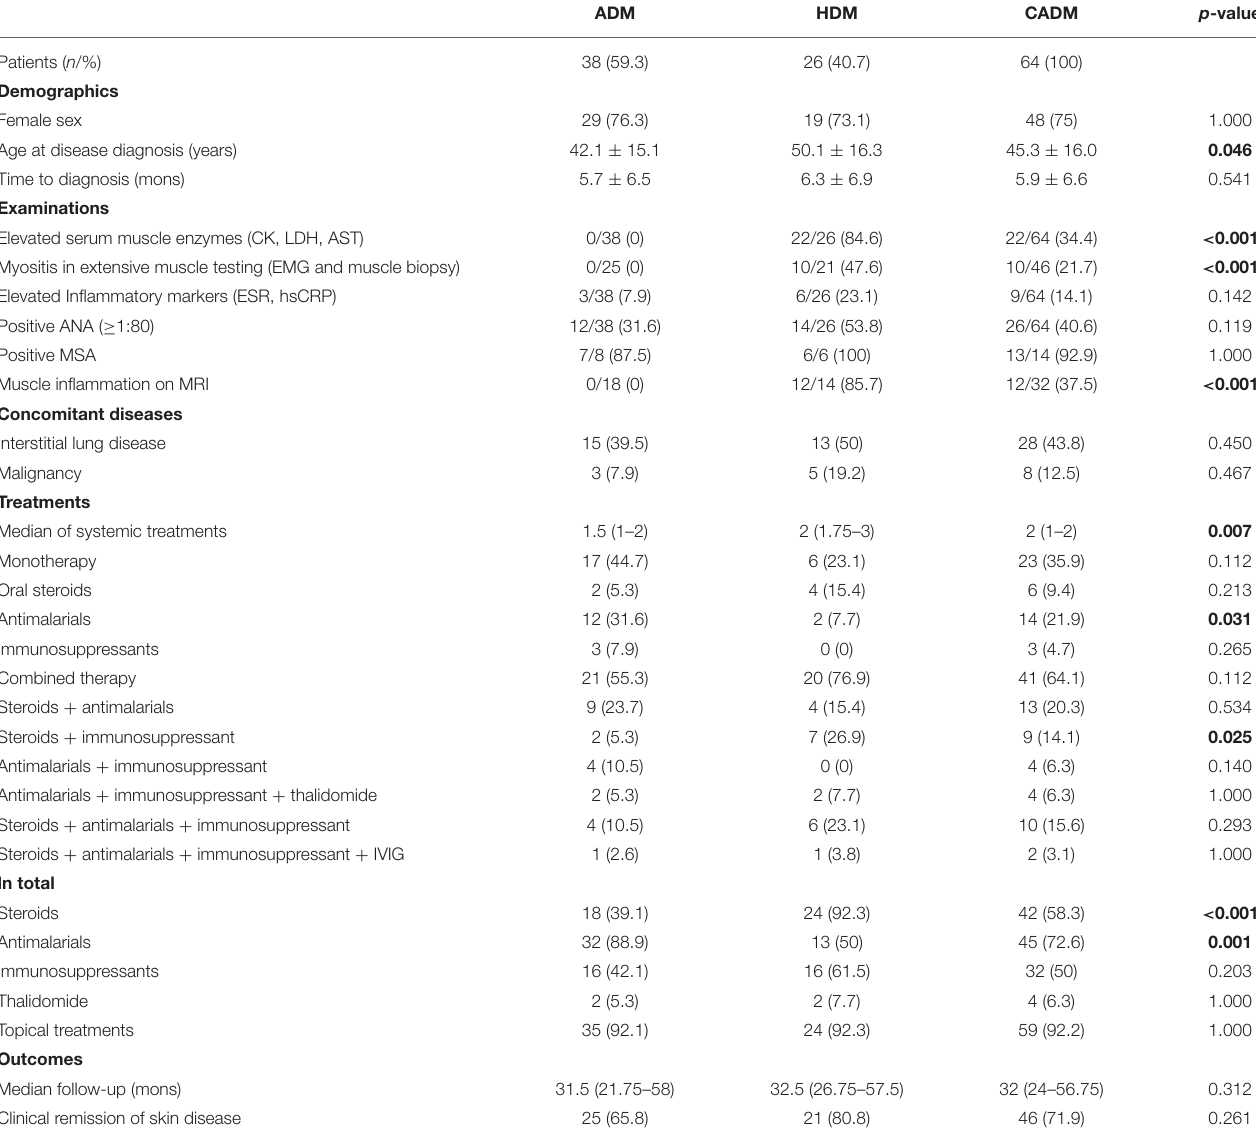
TABLE 1 | Demographics and clinical findings of 64 included patients with clinical amyopathic dermatomyositis. ADM HDM CADM p